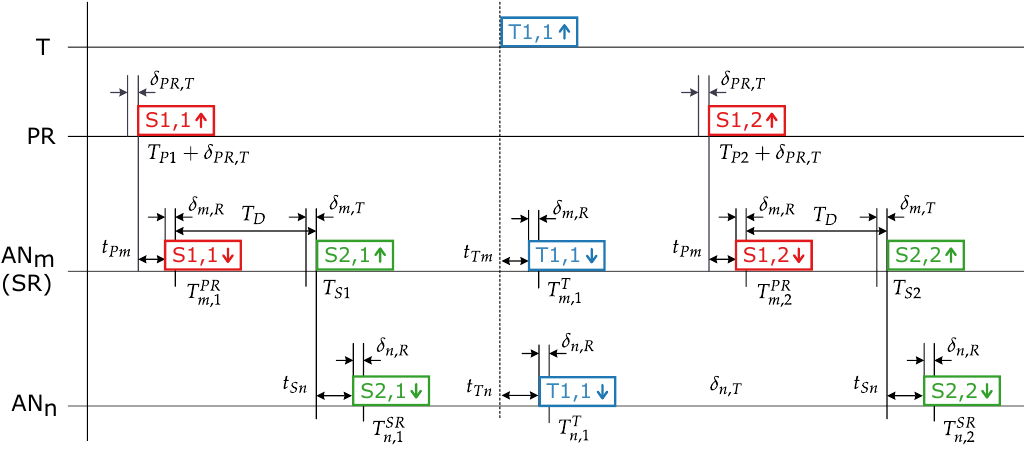
Figure 5. Transmission scheme in the proposed wireless synchronization